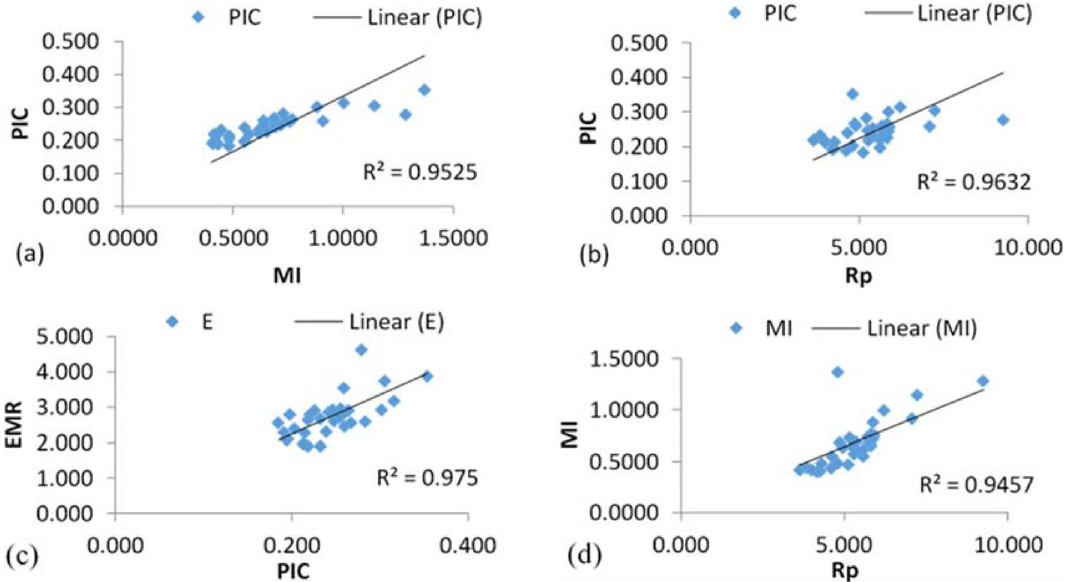
Figure 2. Scatter matrix plot showing relationship (a) MI vs PIC, (b) Rp vs PIC, (c) PIC vs EMR, and (d) MI vs Rp generated by ISSR assay.